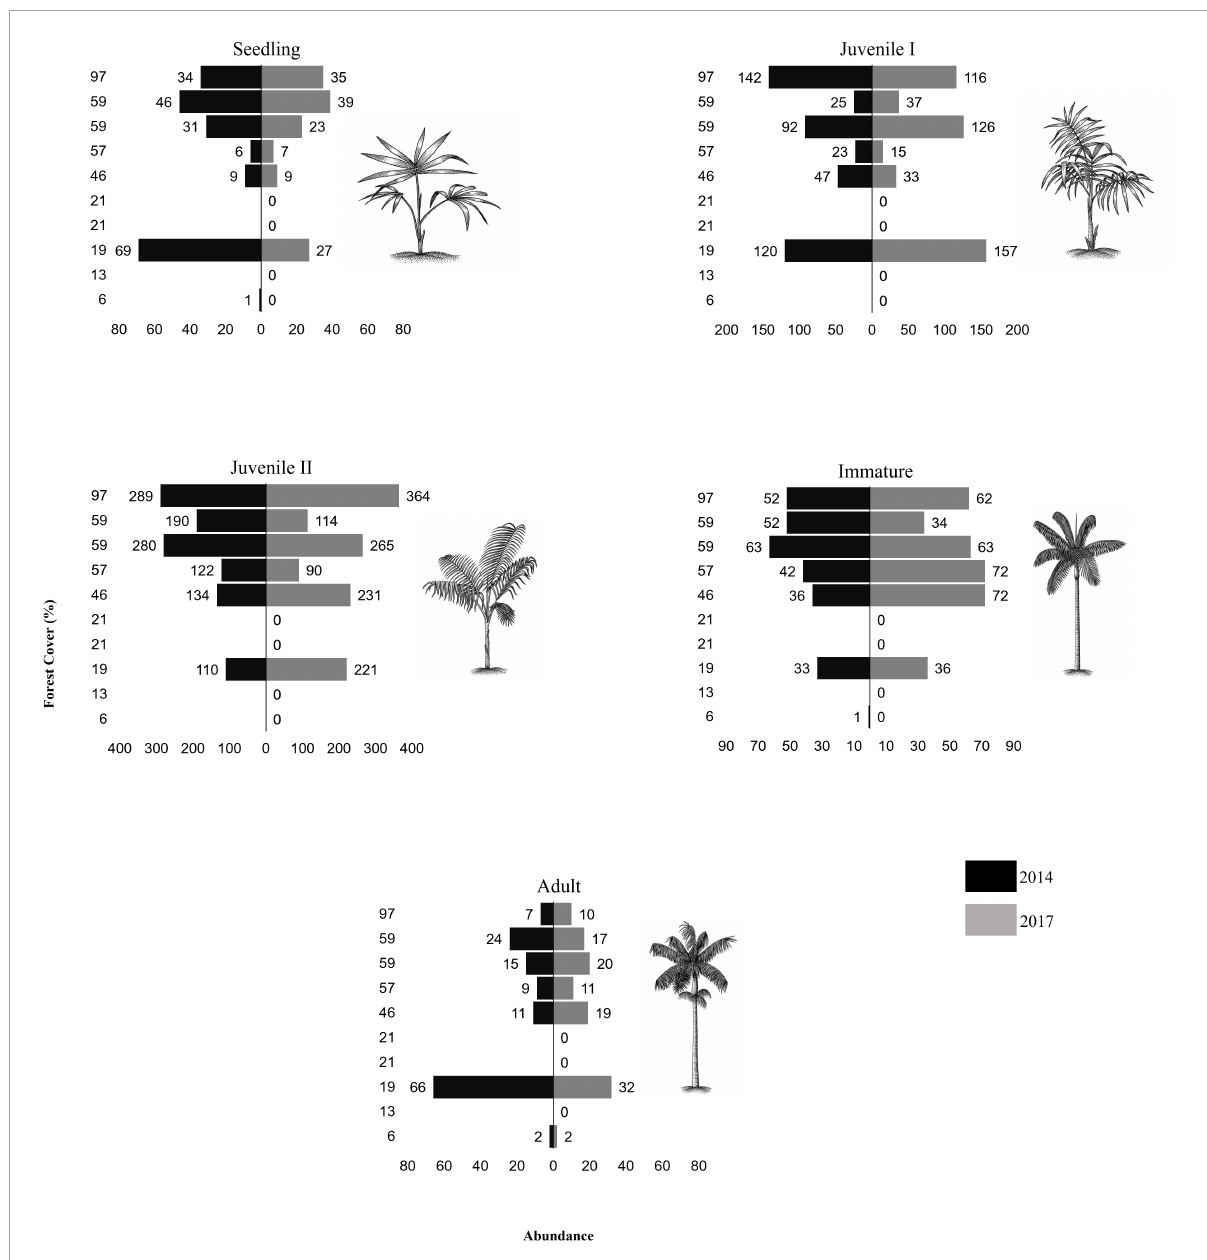
FIGURE2 Abundance of Euterpe edulis in the different ontogenetic stages in the years 2014 and 2017 in a forest cover gradient in ten forest fragments sampled in the Atlantic Forest of Southern